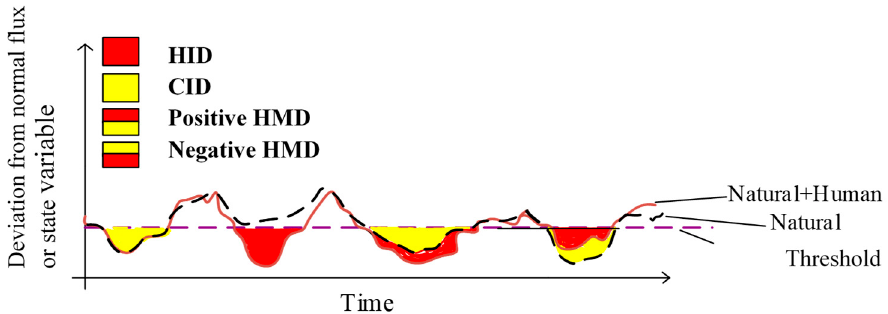
Figure 3. Schematic outline of a hydrological drought types in the Anthropocene (adjusted extended from Van Loon et al., 2016 [6]). A fixed threshold is used for simplicity rather than a variable threshold. CID, HID and HMD are abbreviations of climate-induced drought, human-induced drought and human-modified drought, respectively. The solid brown line, dashed black and dashed purple horizontal lines present the observed time series, simulated time series and threshold, respectively.